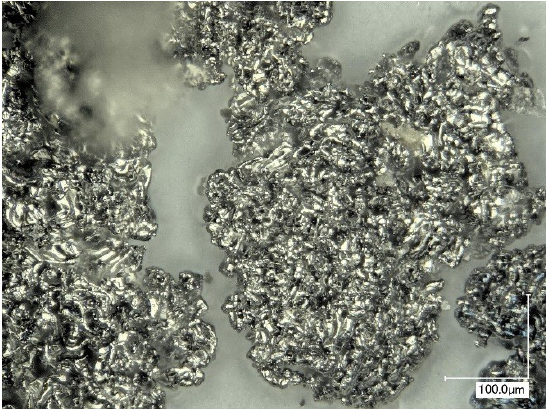
Figure 3. Picture of sponge-like surface structure of AHC 100.29.